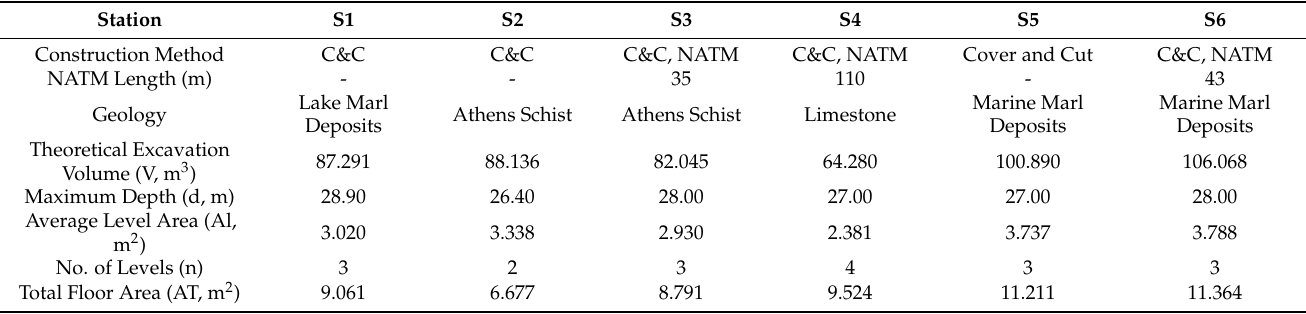
Table 2. Technical characteristics of the underground